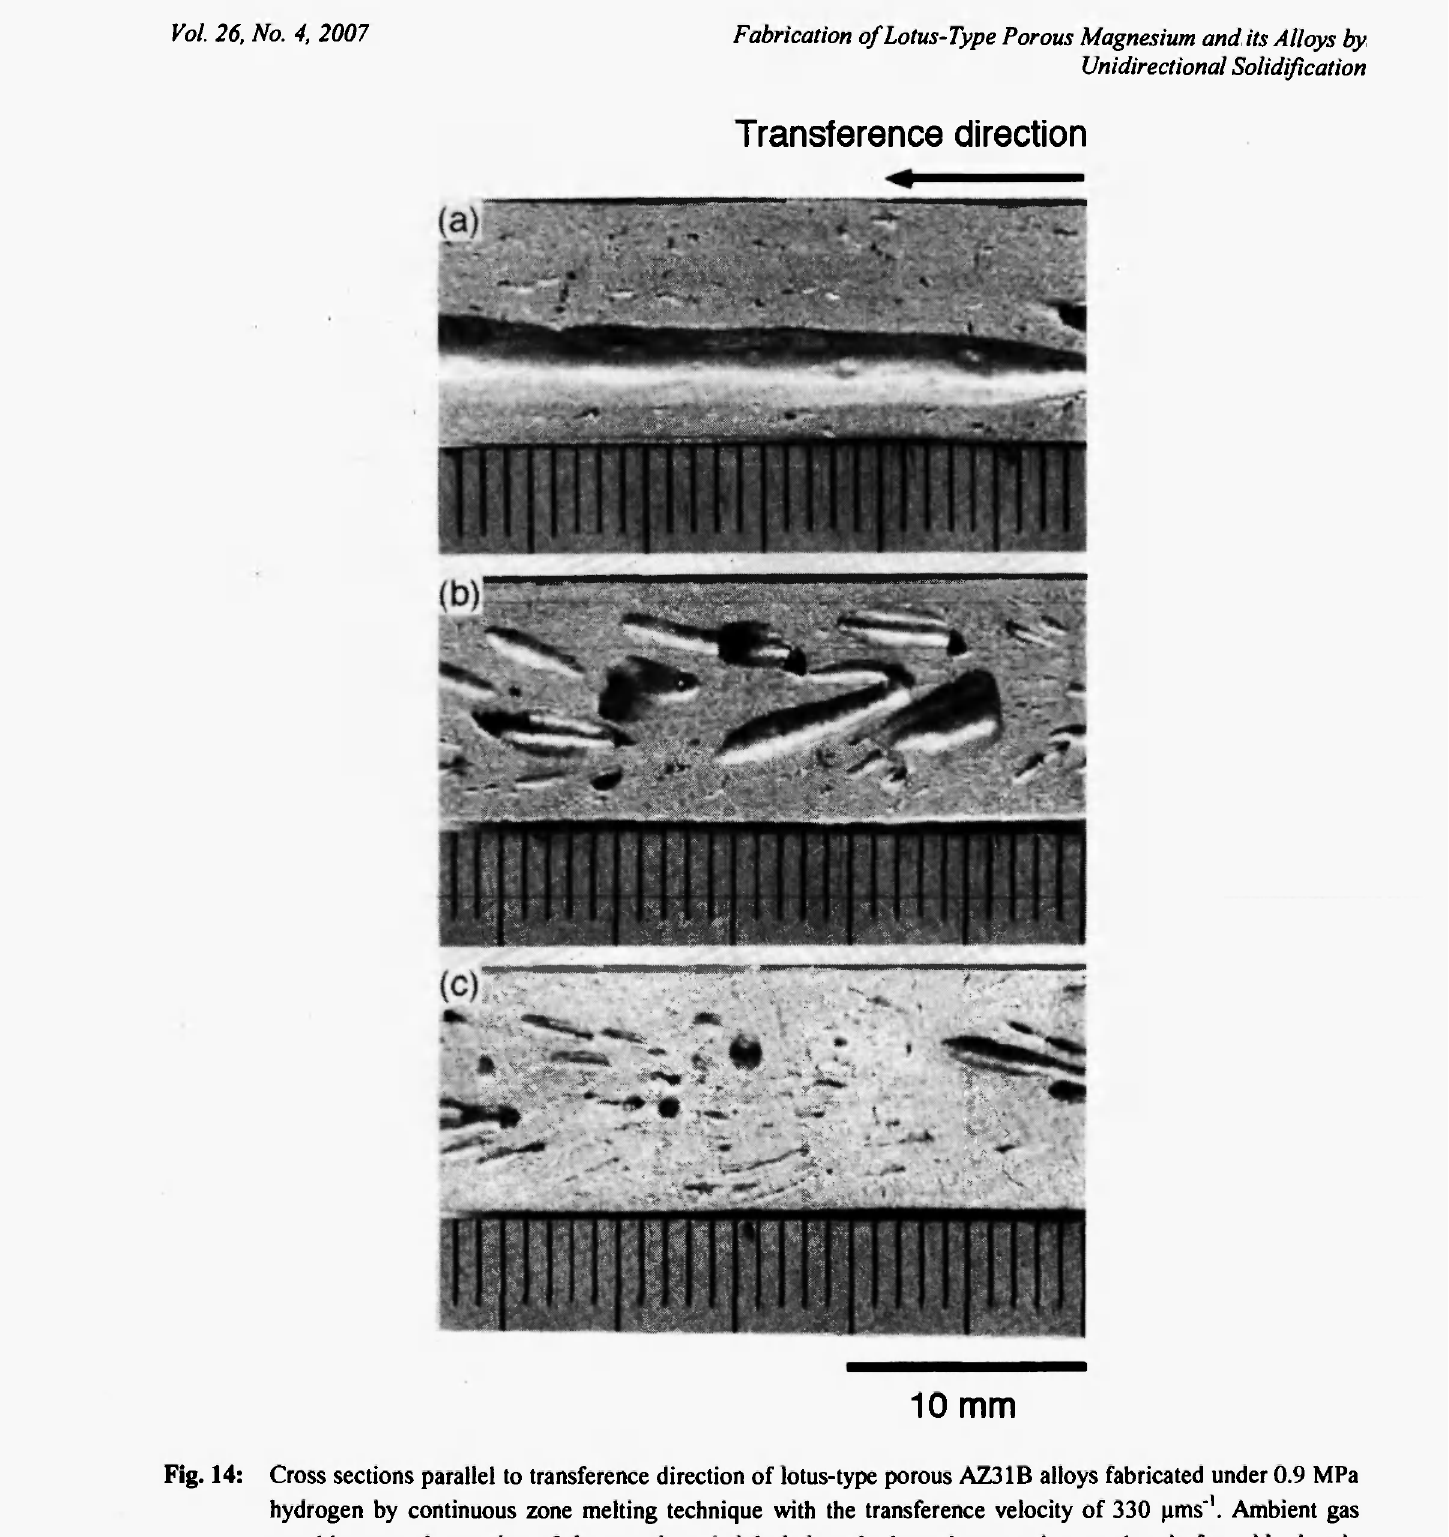
Fig. 14: Cross sections parallel to transference direction of lotus-type porous AZ31B alloys fabricated under 0.9 MPa hydrogen by continuous zone melting technique with the transference velocity of 330 μπ«" 1 . Ambient gas was blown to the portion of the sample rod right below the heated zone using an electric fan with electric voltages of 0 V (a), 40 V (b) and 100 V